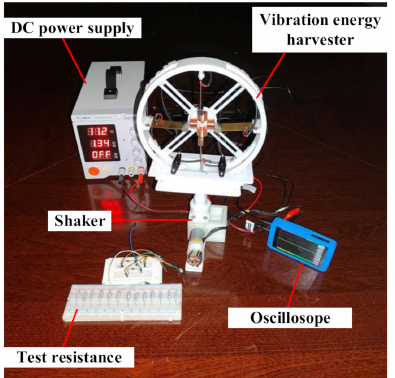
Figure 7. Vibration experimental